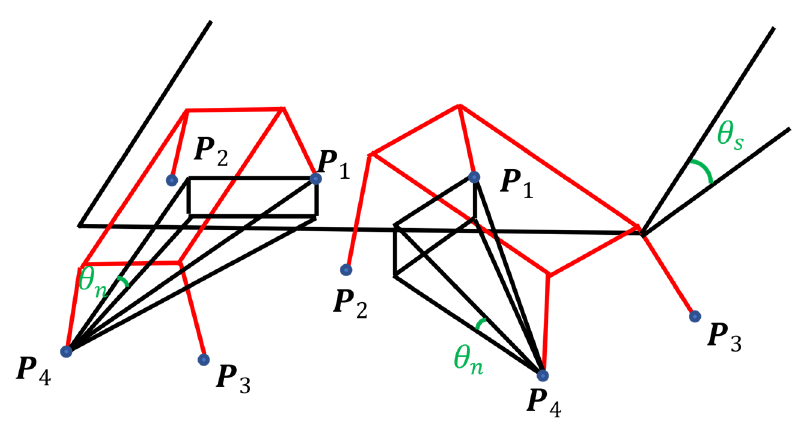
Figure 5. Entering the slope with different directions.